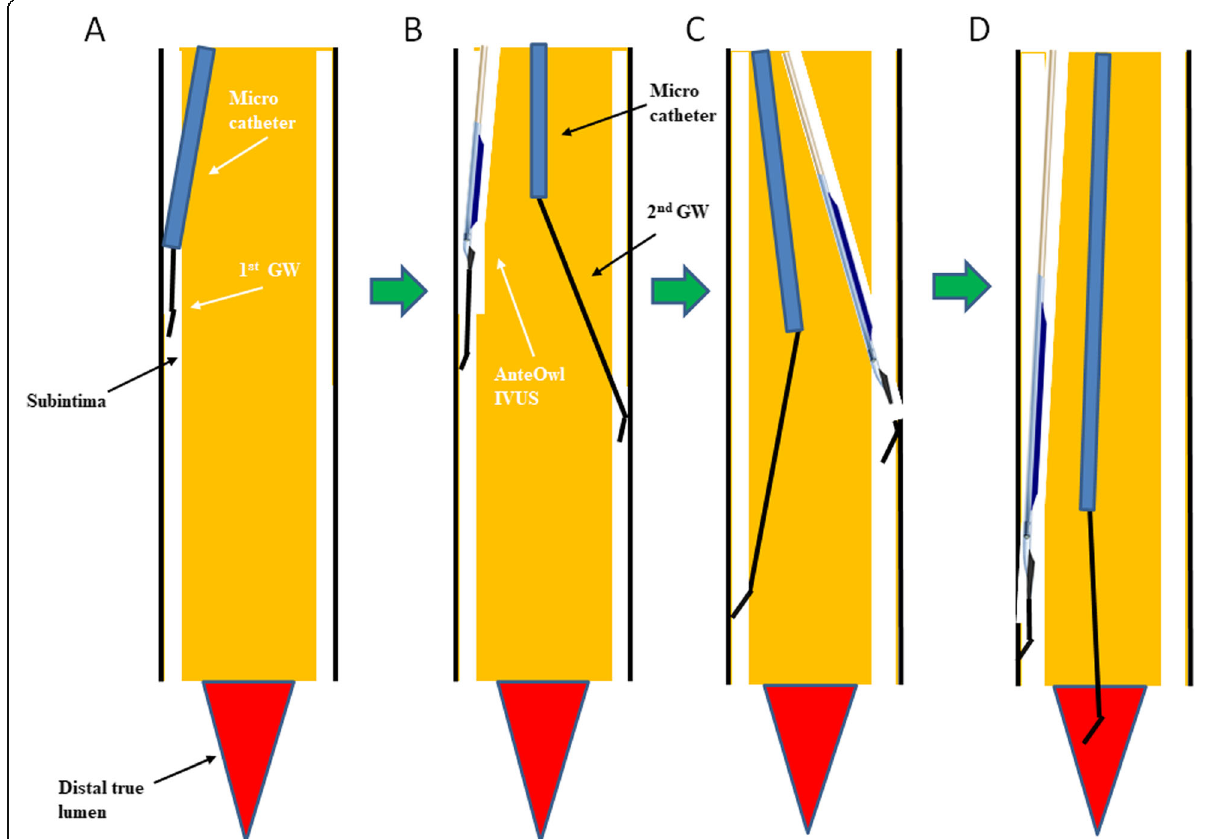
Fig. 4 Schematic diagram of extreme antegrade guidewire crossing by AnteOwl WR intravascular ultrasound (IVUS)-guided parallel wiring to a below-the-knee artery (EXCAVATOR). A The 1st guidewire (GW) with microcatheter is advanced into the subintima. We use the bougie technique with the microcatheter to prepare for IVUS insertion. B The AnteOwl IVUS is advanced along the 1st GW. The 2nd GW with microcatheter is inserted to perform IVUS-guided parallel wiring. The 2nd GW is guided to the intraplaque under real-time IVUS guidance. The 2nd GW is then advanced into the subintima. C The bougie technique is used as shown in ( A) and the IVUS is returned to the subintima. Under IVUS guidance, the 2nd GW is again introduced into the plaque. D Finally, the 2nd GW is passed from the distal plaque to the distal true